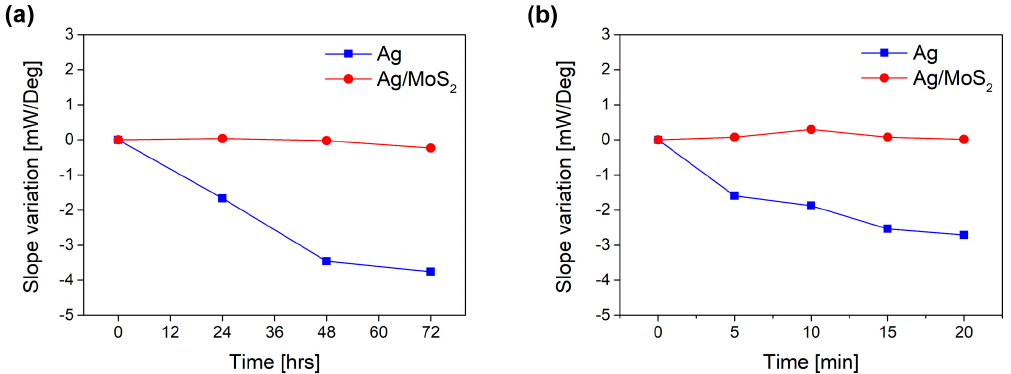
Figure 5. The slope variation of SPR signals of bare Ag SPR substrate (blue square) and Ag/MoS 2 SPR substrate (red circle) under ( a ) slow and ( b ) fast oxidation conditions. The slope variation of the SPR signal, which is defined as the intensity change of reflected light according to the angle, are represented according to measurement time.